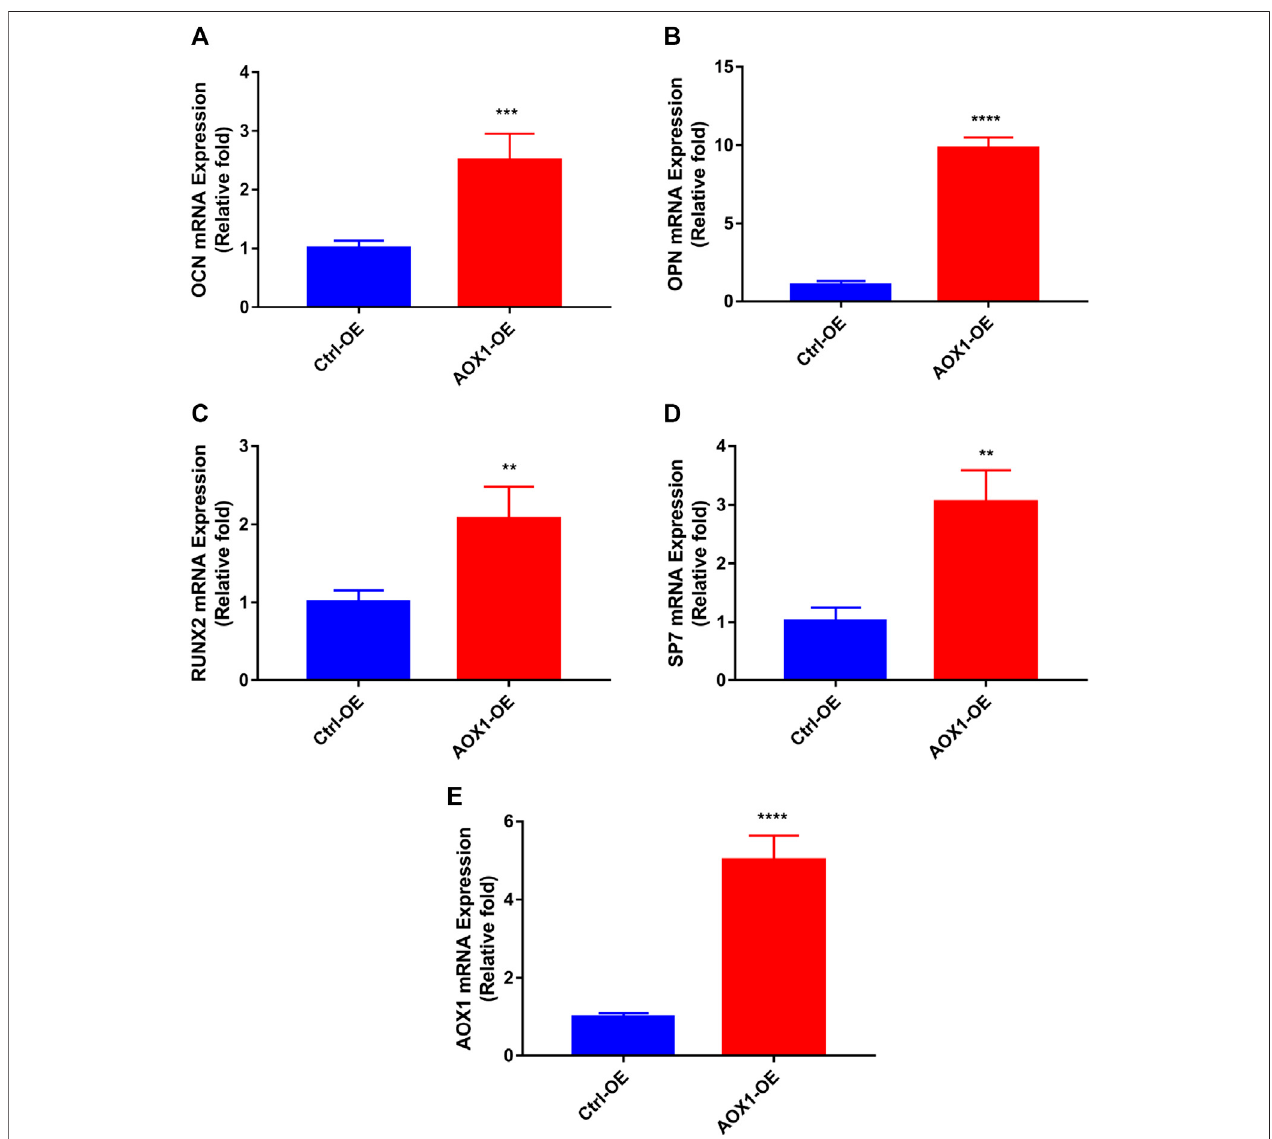
FIGURE 7 | Effects of AOX1 overexpression on osteo-speci fi c genes. (A – D) Relative mRNA expression of osteo-speci fi c genes and (E) AOX1 on day three of osteogenesis after AOX1 overexpression. The mRNA expression levels were normalized to that of 18S ribosomal